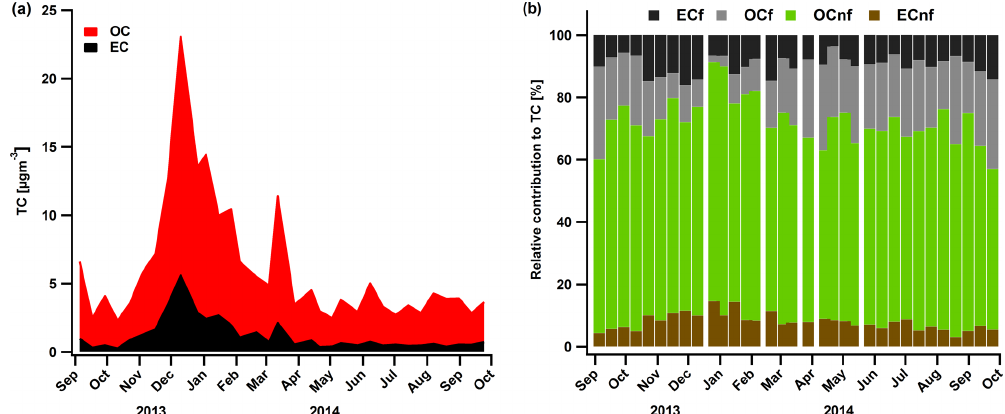
Figure 2. Time series of OC and EC (a) concentrations in PM 10 . 14 C analysis results with the relative contributions of EC fossil, OC fossil, OC non-fossil and EC non-fossil to the TC (b)